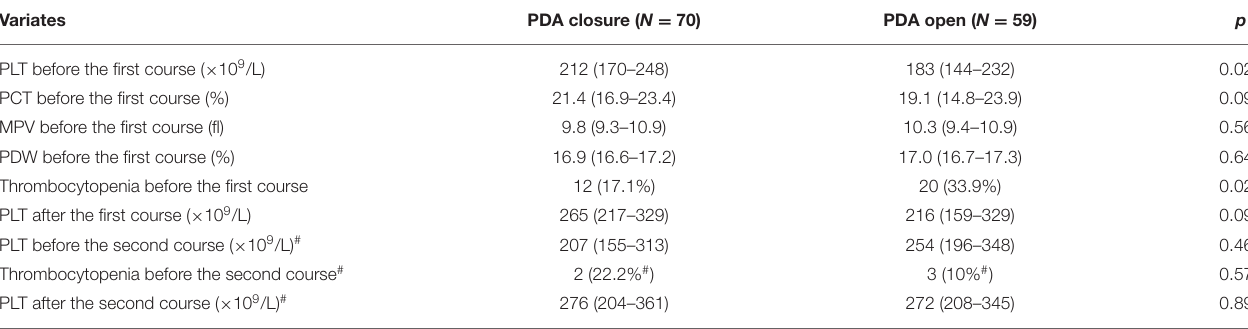
TABLE 2 | Platelet index before and after the ibuprofen treatment.